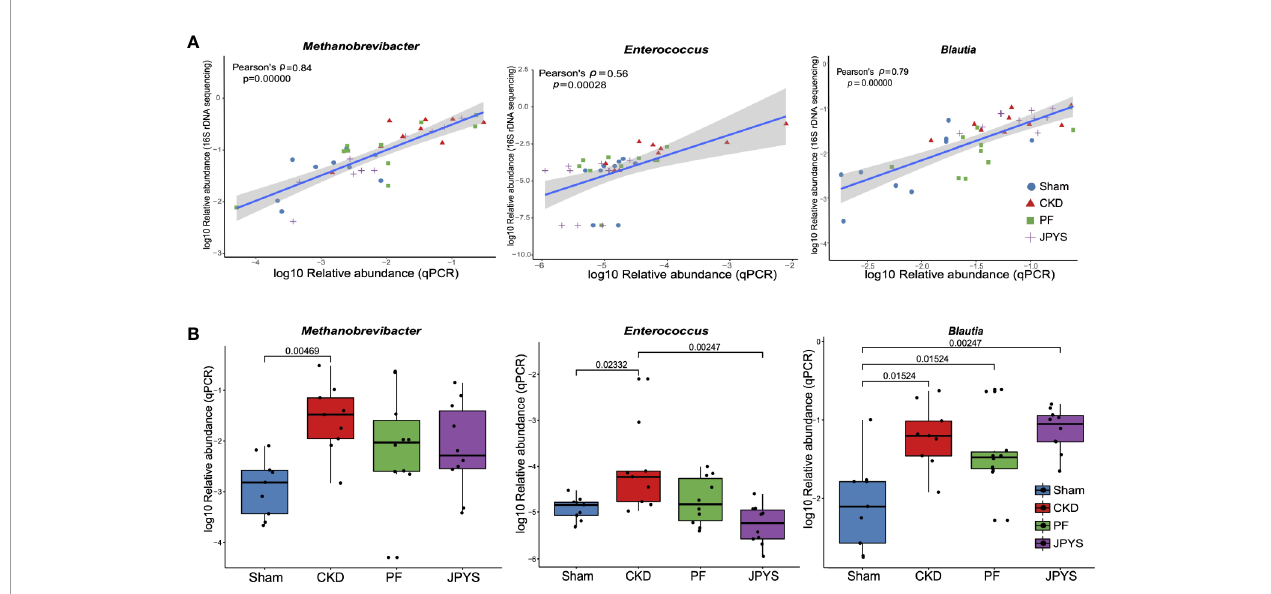
FIGURE 4 | qPCR validation of the identi fi ed keystone microbiome markers. (A) Pearson correlation between relative abundance of the genera Methanobrevibacter, Enterococcus and Blautia from 16S rDNA sequencing and qPCR data. Colors and shapes of the plot symbols indicate samples from different treatment groups. Shaded area represents the 95% con fi dence interval for the regression line. (B) Relative abundance of the genera Methanobrevibacter, Enterococcus, and Blautia across treatment groups, as detected by qPCR. Variations between groups were tested by Wilcoxon rank-sum test with FDR correction. Only signi fi cant differences between groups ( p < 0.05) were annotated. FDR, false discovery